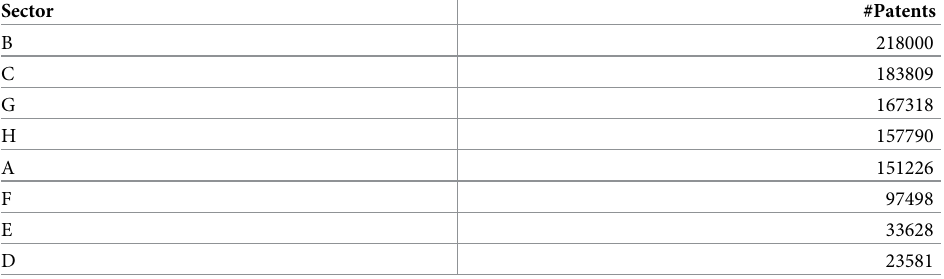
Table 1. Sector wise distribution of